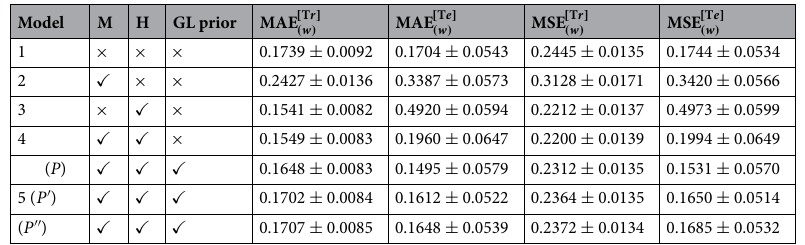
Table 6. Training and testing errors of Models 1–5 with standard deviation for simulated data with thirty provinces. The formulas of errors are detailed in Sect. B (Eq. (S5)) of Supplementary Information. Remarks for Columns 1–4 and presented results of errors are the same as those in Table 4. In addition, the remarks for the choice of µ ∗ = 10 1.8 in Model 5 and the partitions P , P ′ , and P ′′ are the same as those in Table 5.